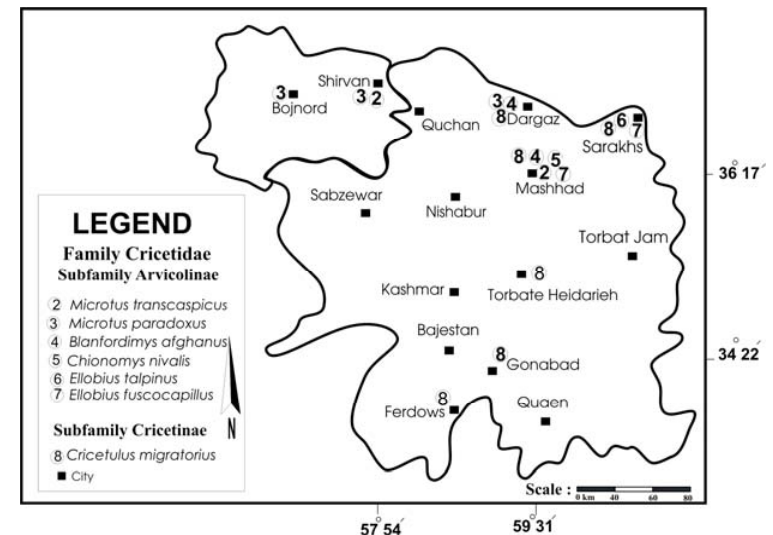
F IG . 2. - Map of northeastern Iran with collecting sites for different species of Family Cricetidae, indicated with numbers (the numbers are the same as in text and tables